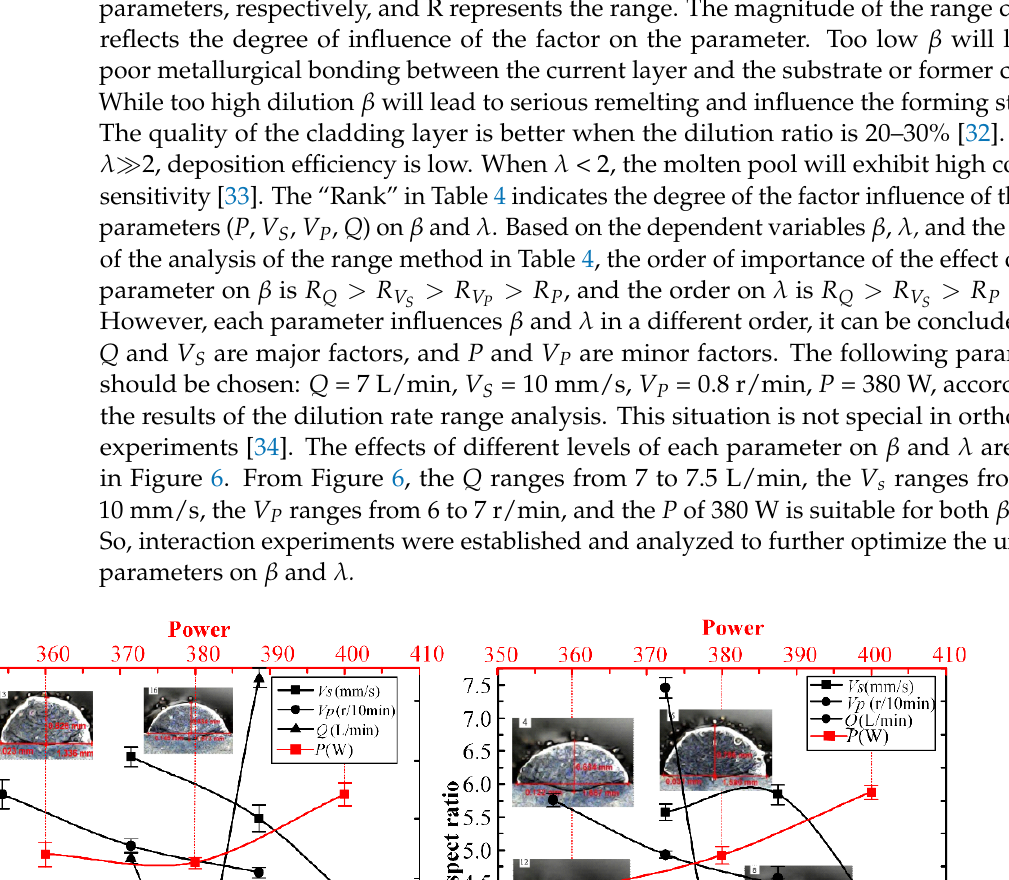
Table 5. Results of the interactive experiment.